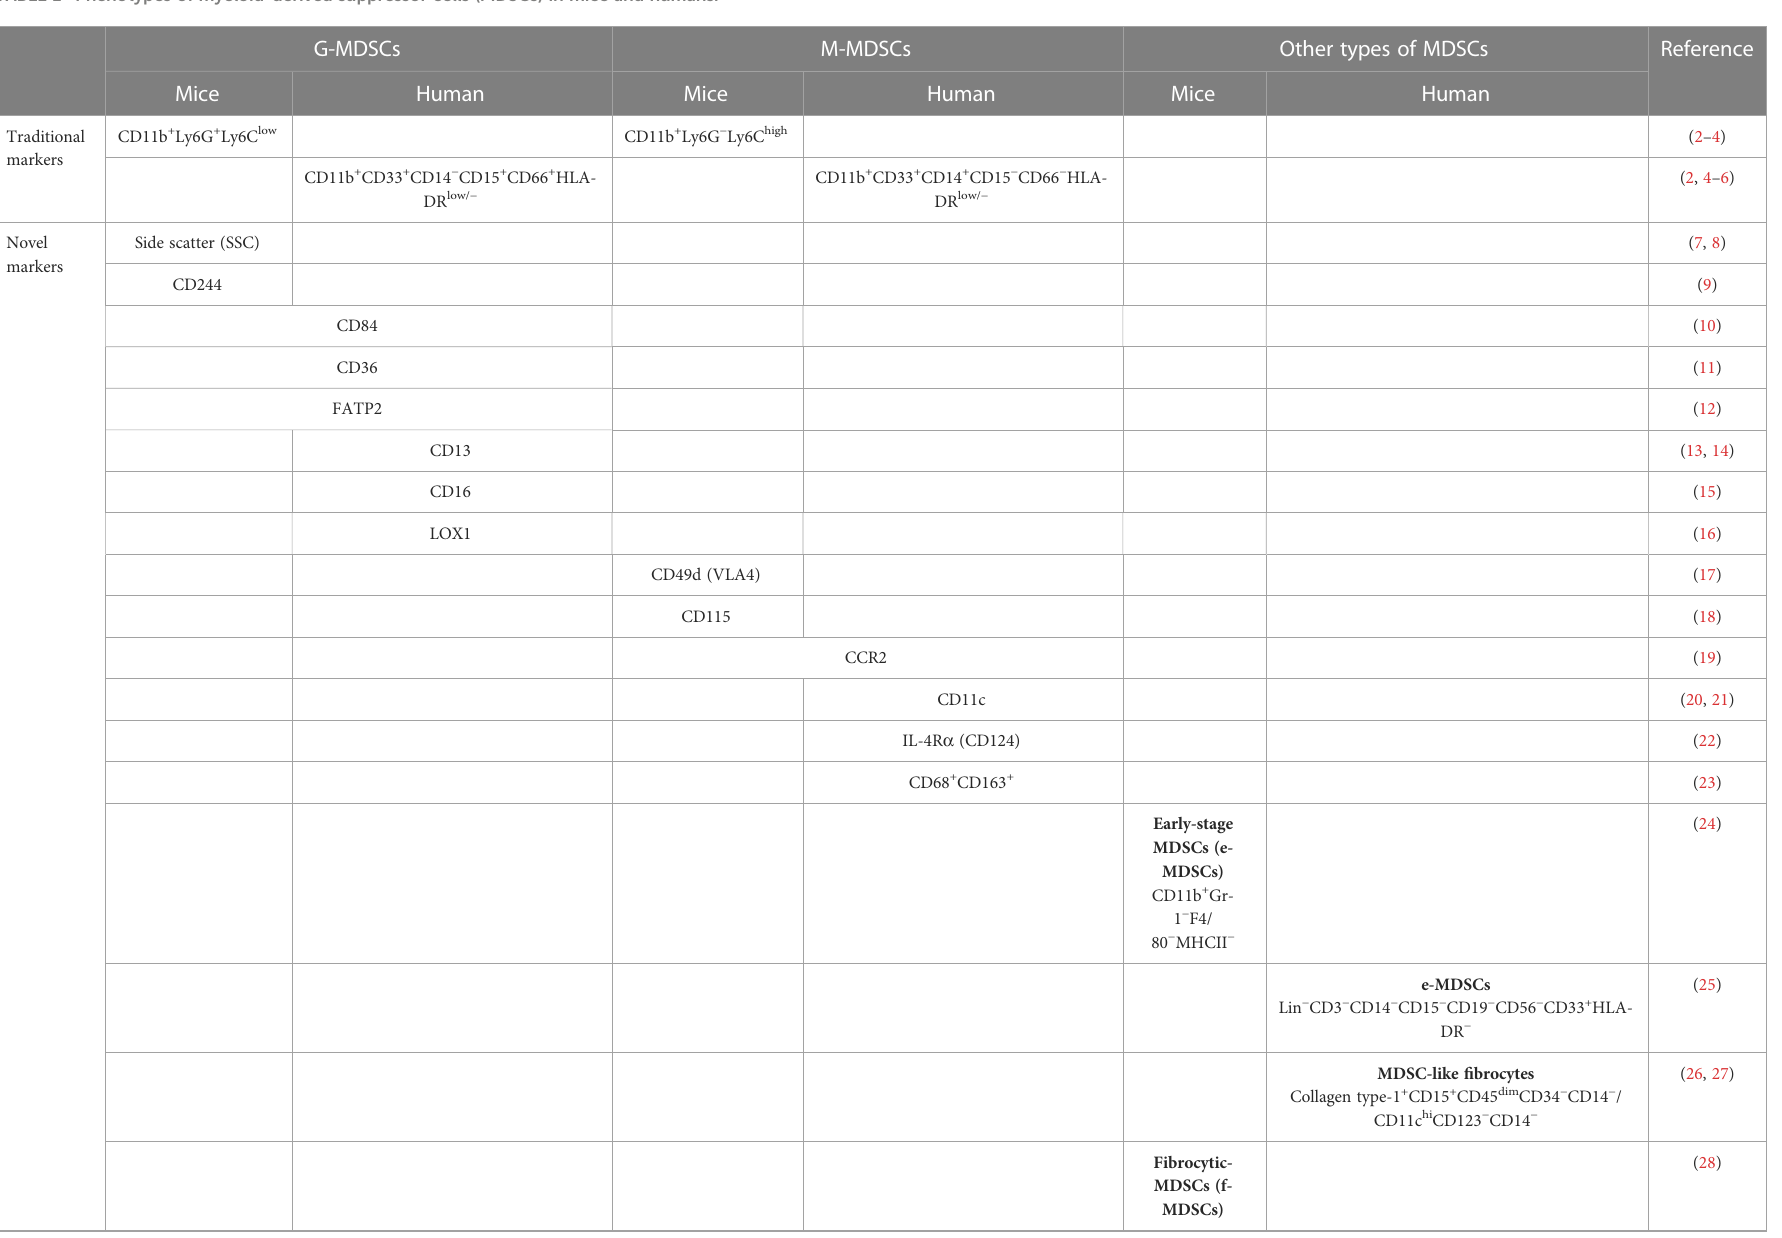
TABLE 1 Phenotypes of myeloid-derived suppressor cells (MDSCs) in mice and